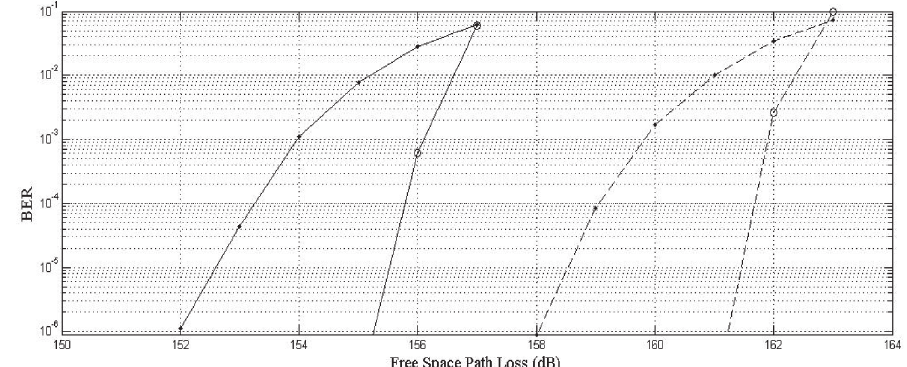
Fig. 2. Dependence of error probability for a BPSK modulation scheme on free space path loss in the uplink and the downlink: dots indicate values without coding, circles – with convolutional coding (rate ¾, constraint length K = 7); 20 K noise temperatures of satellite and ground receivers are indicated by dashed lines and 290 K by solid lines; HPAs back-off level is 7 dB; phase and frequency offsets are equal to zero, d 1 = d 2 = d 3 = d 4 = 1.0 m; satellite